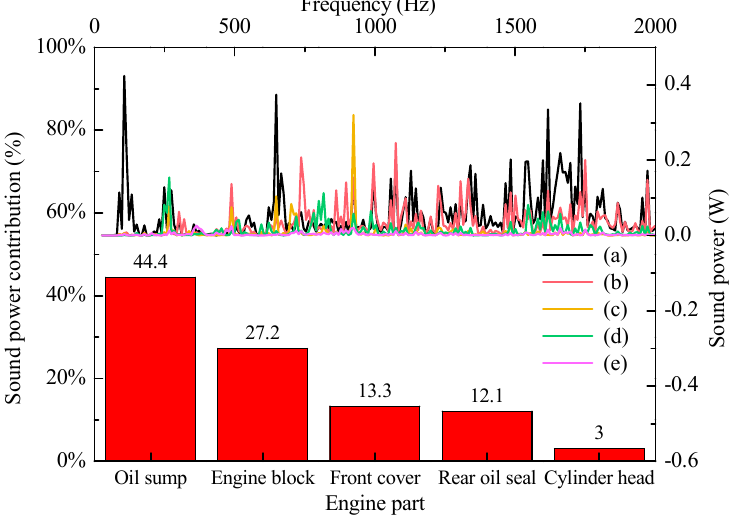
Figure 9. Sound power spectrum and contribution diagram of five engine parts (A-weighted). (a) Oil sump. (b) Engine block. (c) Front cover. (d) Rear oil seal. (e) Cylinder head.